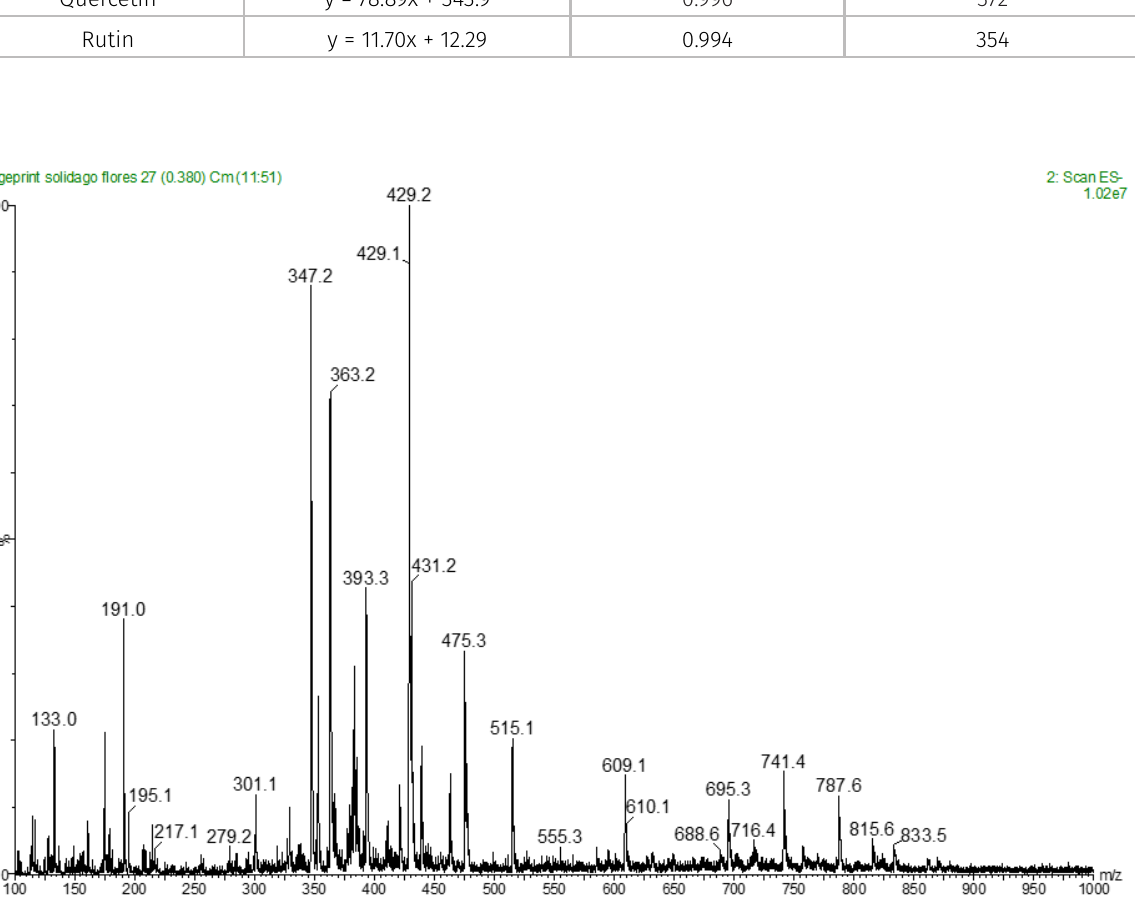
Figure 1. ESI(-)-MS spectrum of S. microglossa flowers.